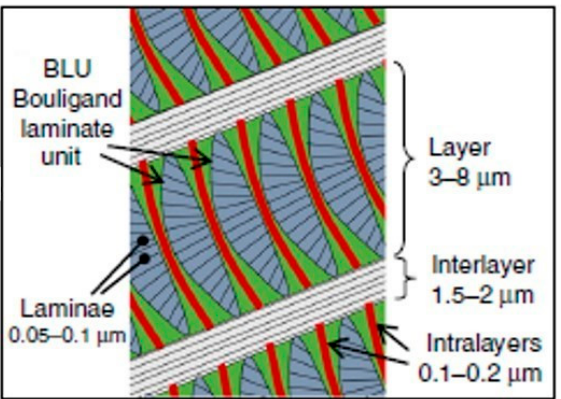
Figure 4. ( a ) Schematic view of the scorpion layered endocuticle and Bouligand structure; ( b ) SEM overview of the layered architecture. Each layer consists of tightly nested Bouligand laminate units (BLU).